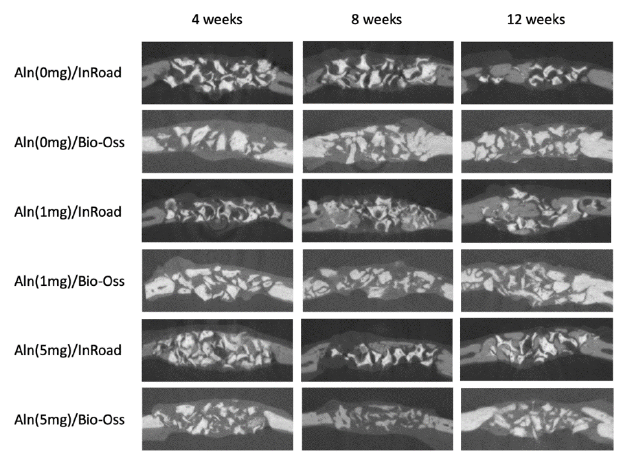
Figure 6. Micro-computed tomography (CT) analysis used to observe the amount of bone formation at the 4, 8, and 12 weeks after implantation. The amount of bone formation was observed using the calculated bone mineral density and bone formation volume (%BV). For the defect area, all tissues of the newly formed bone were